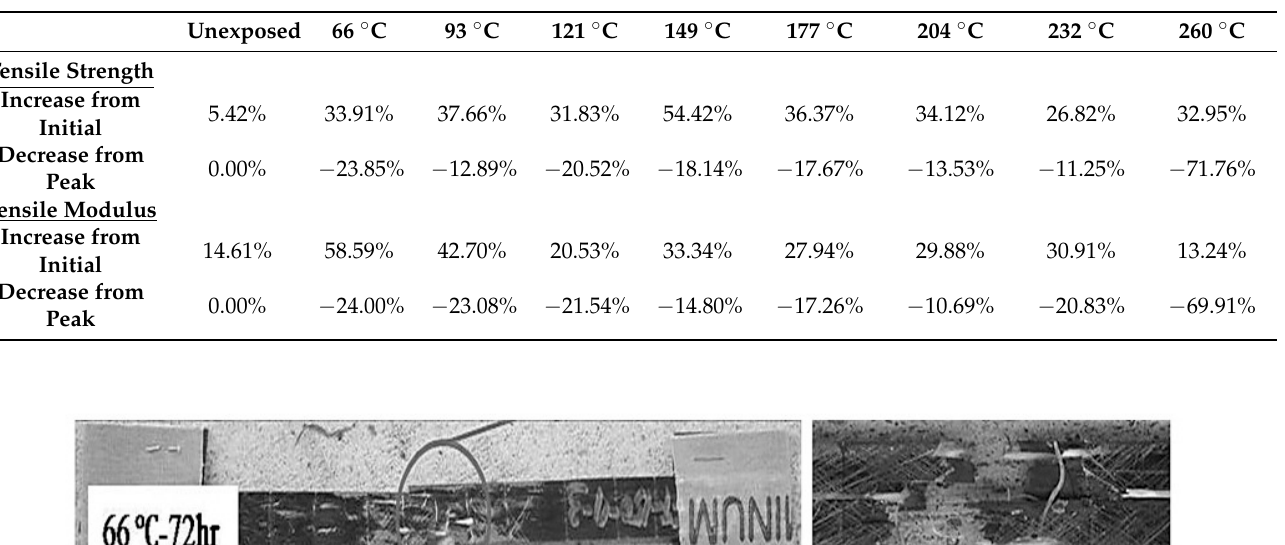
Table 1. Percentage Change in Characteristics.